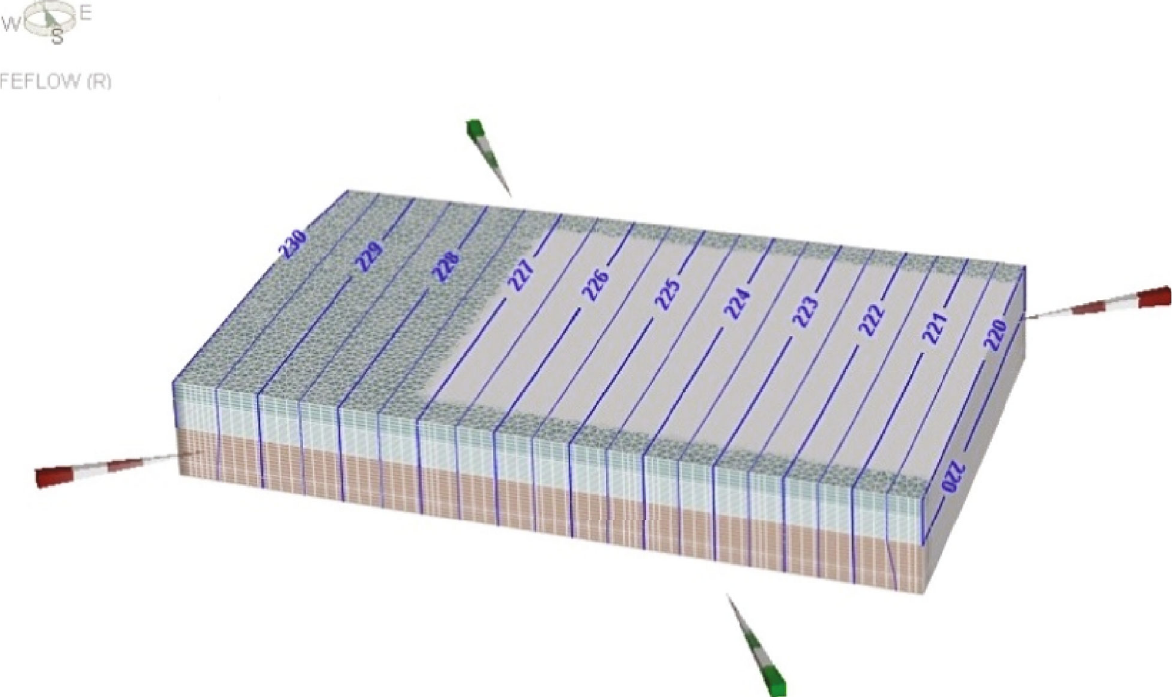
Figure 4: FEFLOW 3D model view. The two di ff erent units are distinguished with di ff erent colors (unit 1 in light blue and unit 2 in orange). Blue lines indicate the hydraulic